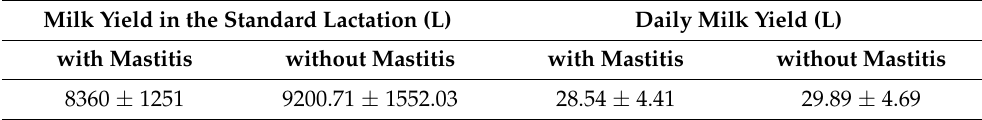
Table 1. Daily milk yield and milk yield in the standard lactation (milk yield = 305 days in lactation) in cows with and without diagnosed clinical mastitis from the total cow population (average ± SD). Milk Yield in the Standard Lactation (L) Daily Milk Yield (L) with Mastitis without Mastitis with Mastitis without Mastitis 8360 ± 1251 9200.71 ± 1552.03 28.54 ± 4.41